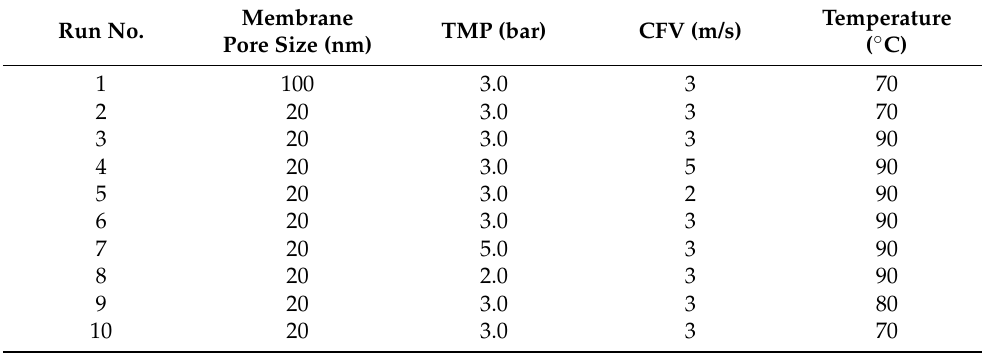
Table 3. Operating conditions of the membrane modules. Run